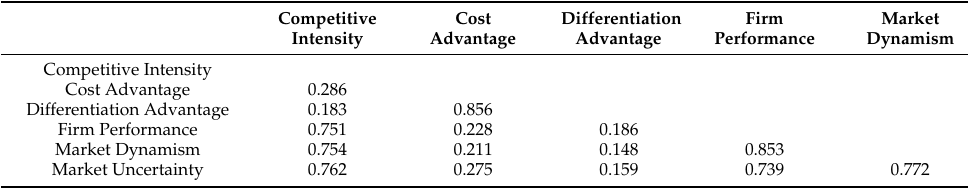
Table 3. Heterotrait–monotrait ratio (HTMT).